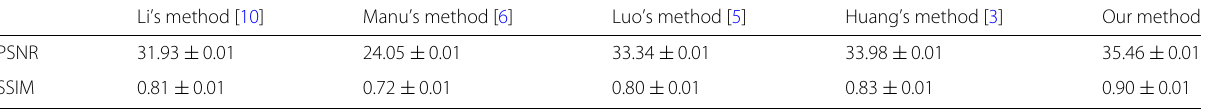
Table 1 Quantitative comparison of different methods on synthetic rainy